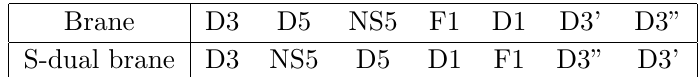
Table 3 . S-duality action on branes and strings.